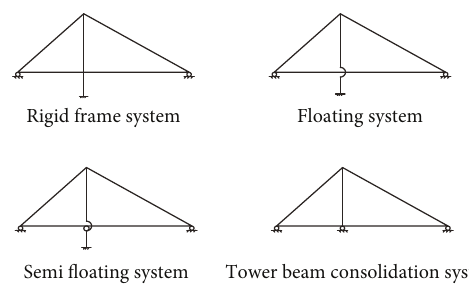
Figure 9: Several systems of a cable-stayed bridge with a single